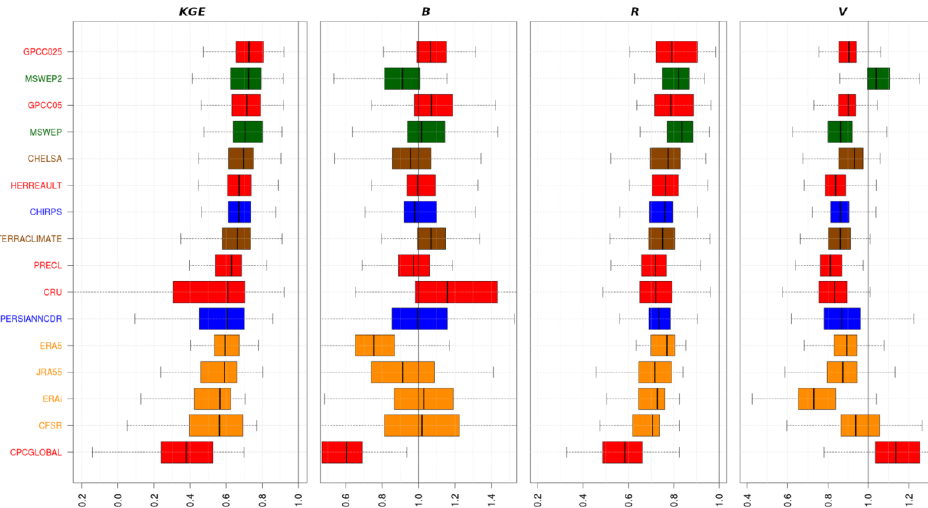
Figure 3. Boxplot of the KGE index and its components B (bias), R (correlation) and V (variability). The names of the GPP are colored according to data source considered in its development (red: stations; brown: stations and reanalysis; blue: stations and satellites; orange: reanalysis and green: multisources). The GPP have been sorted according to the median value of KGE index. In all the cases the optimal value is 1.0. Atmosphere 2020 , 11 , x FOR PEER REVIEW